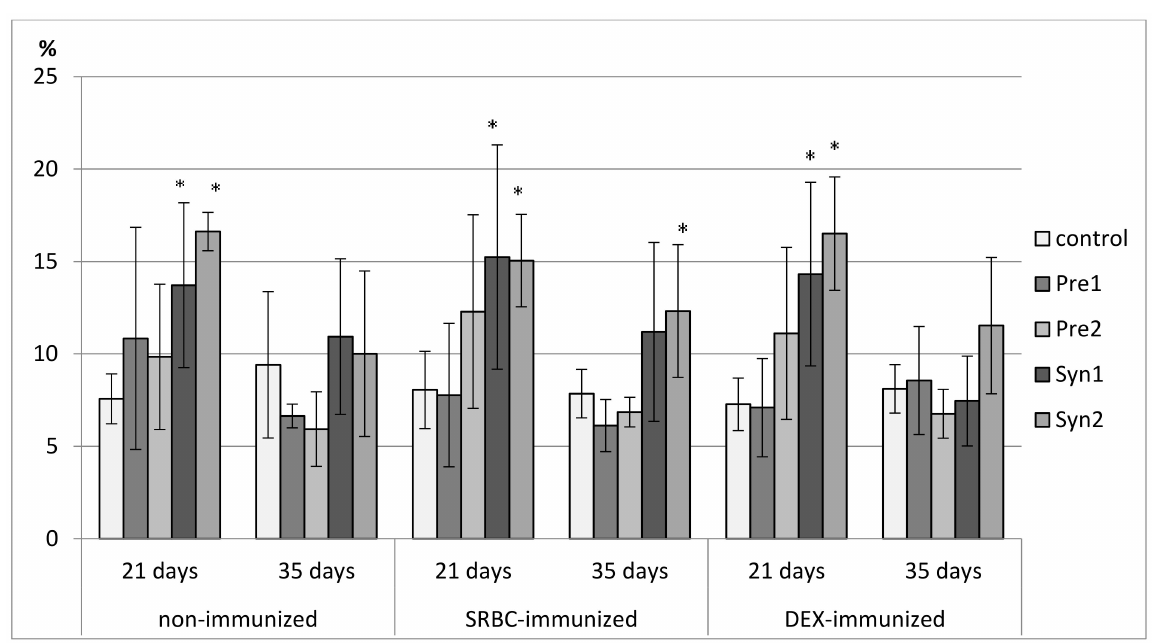
Figure 6. The percentage of CD3 + TCR γδ + cells in the thymus of chicken broilers after in ovo injection of the investigated prebiotics or synbiotics. The data are expressed as the mean ± SD. Data with a symbol (*) denote a significant difference with respect to the control group ( p <